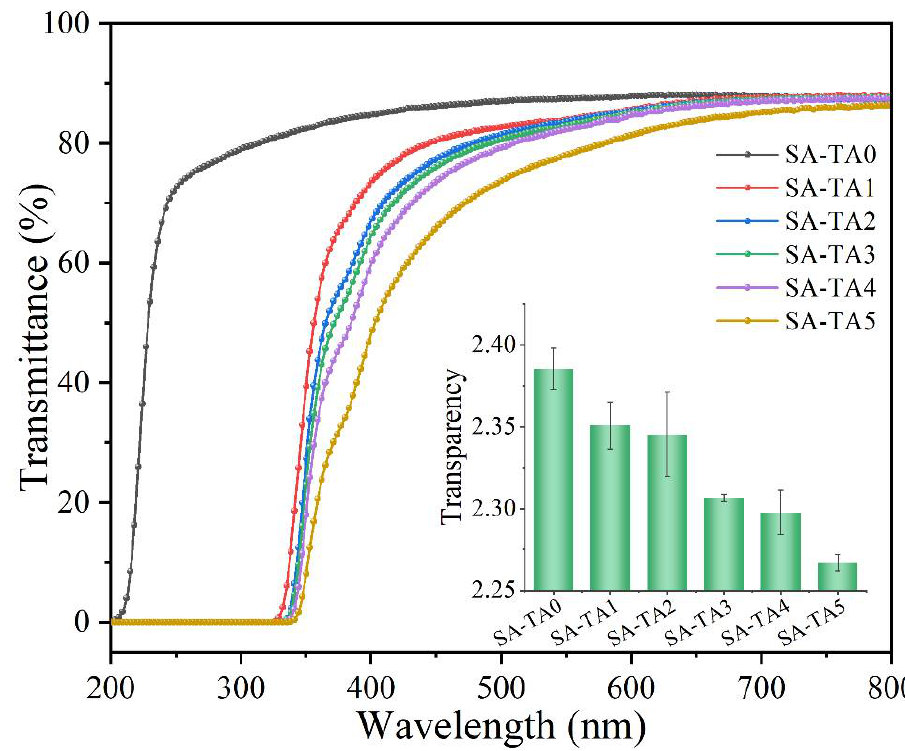
Figure 3. UV-vis light transmittance of neat SA and SA-TA films (insertion is the transparency of all films at 600 nm).